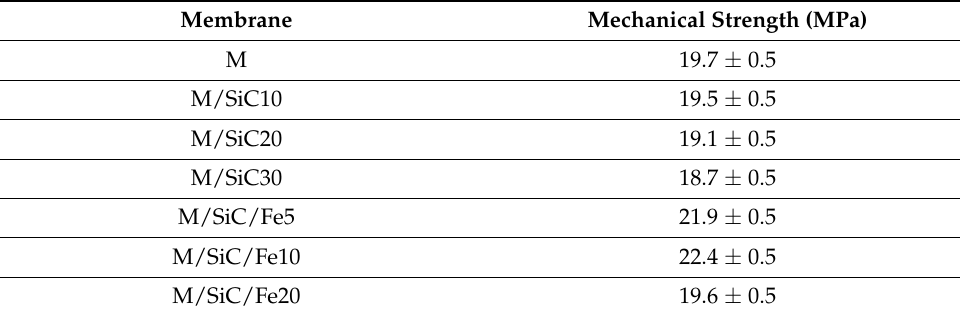
Table 5. Flexural stress (MPa) of MF